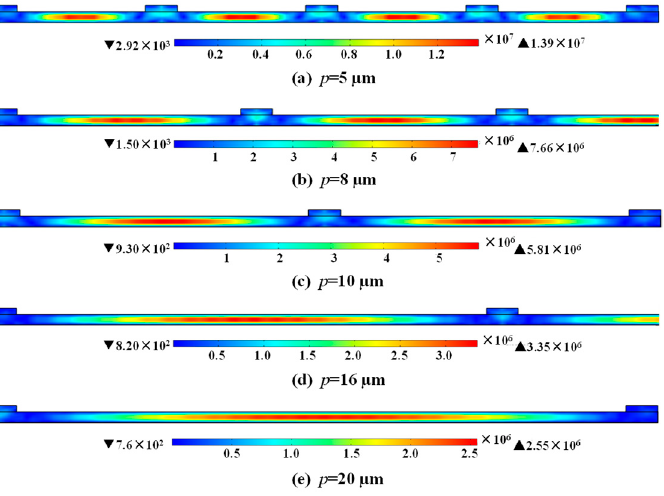
Figure 9. The simulated stress distribution at resonance as ( a ) p = 5 µm, ( b ) p = 8 µm, ( c ) p = 10 µm, ( d ) p = 16 µm and ( e ) p = 20 µm, while the width of electrode is maintained at 1 µm.